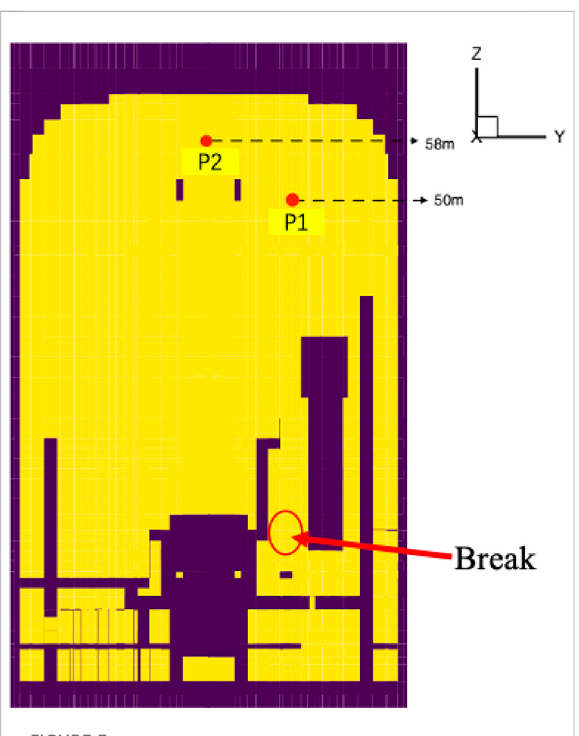
FIGURE 3 Two monitoring points for recording local fl ow